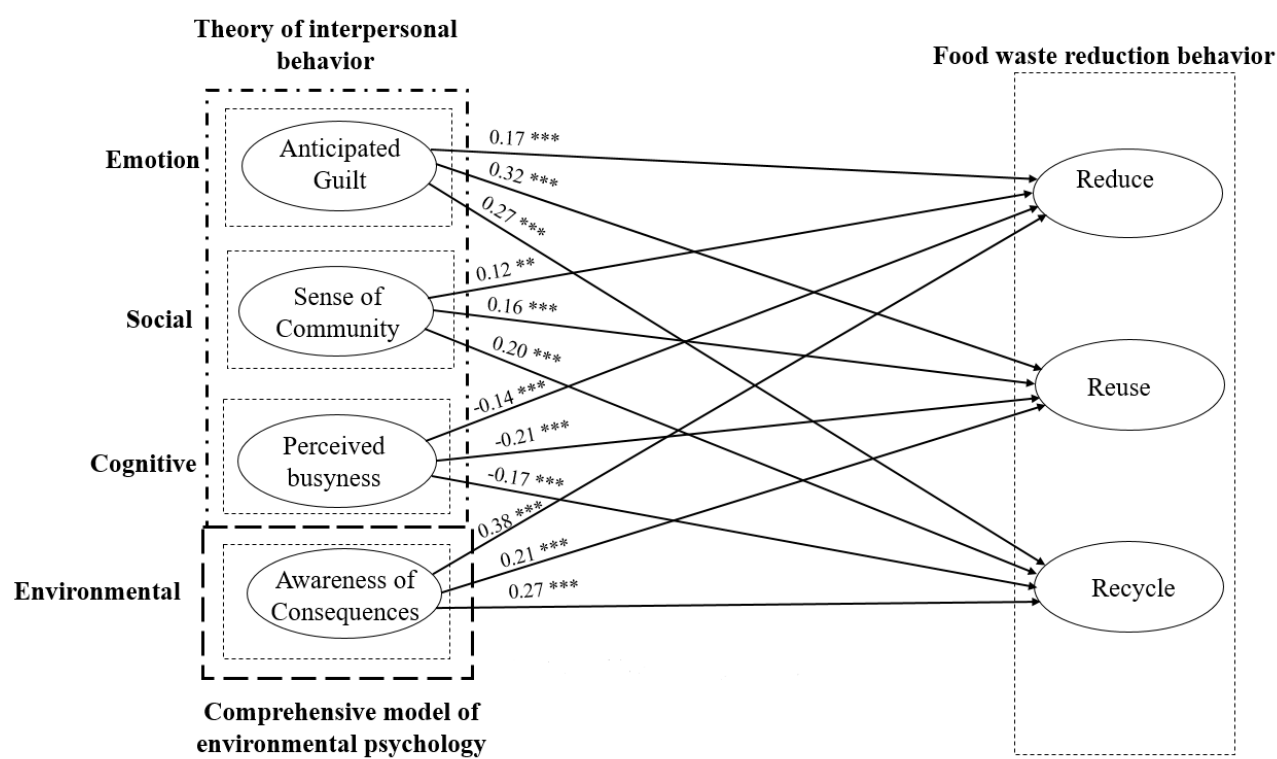
Figure 2. Structural Model. Notes: *** p < 0.001, ** p < 0.01.